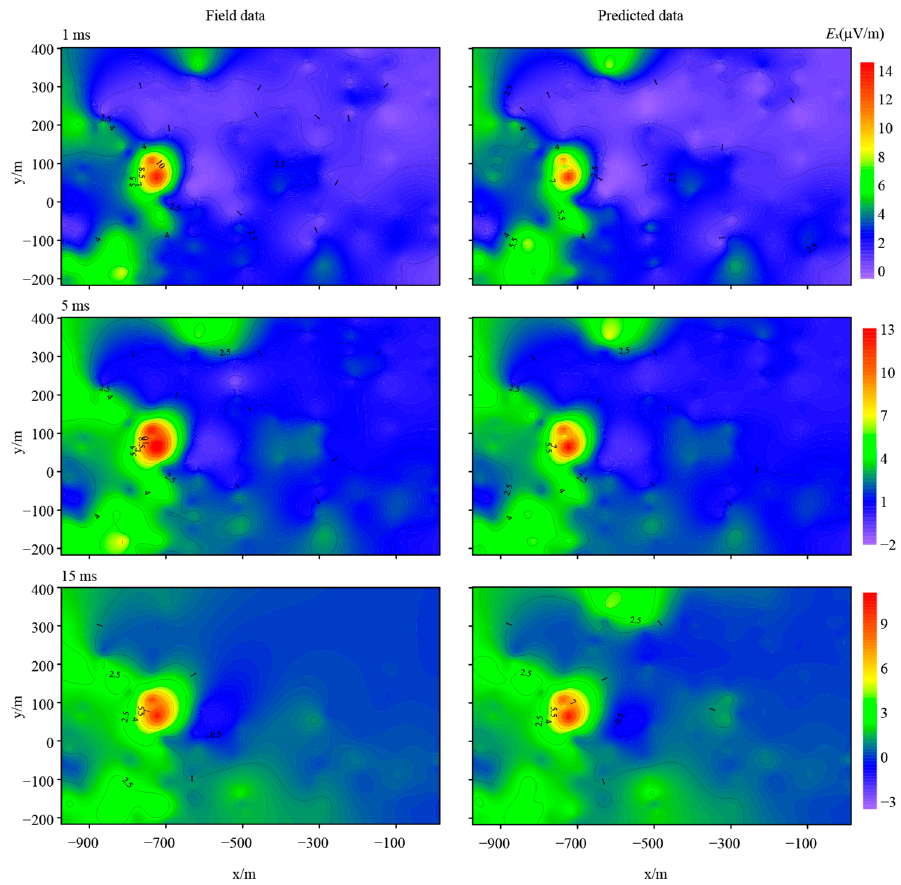
Figure 13. Meshes for our dual-mesh inversion of survey data from Daye, China.